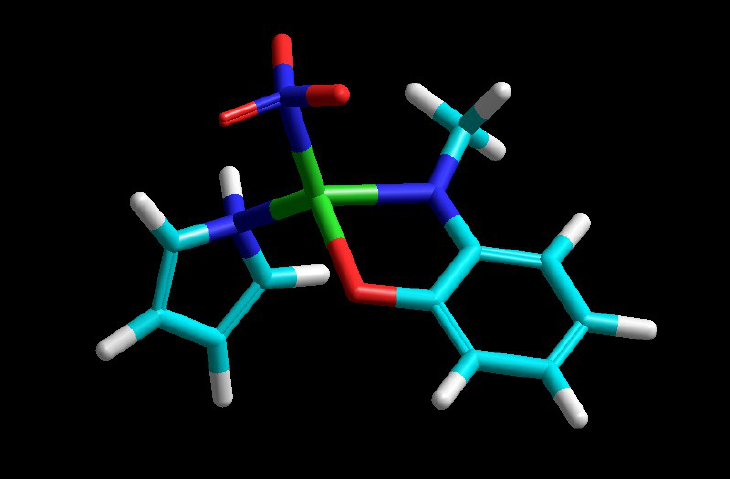
Figure 4. Energy minimized structure of cobalt(II)